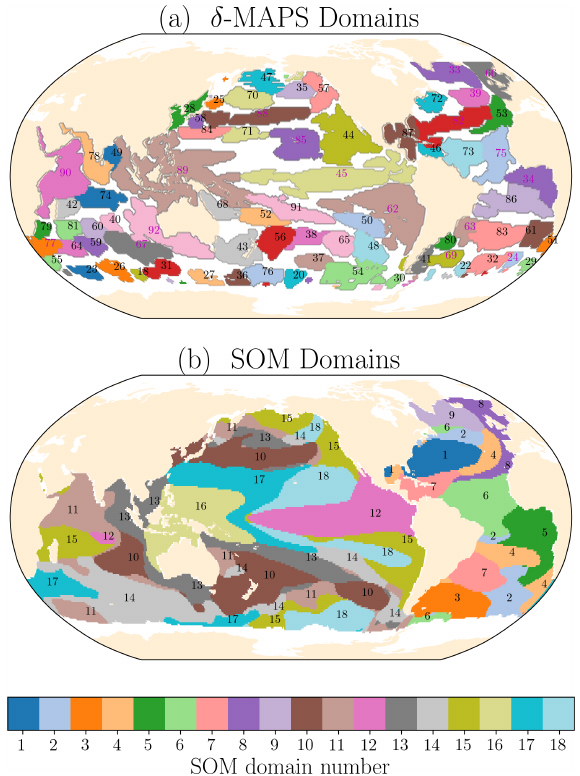
Figure 2. Domains of coherent sea-level variability: (a) δ -MAPS method (92 domains) and (b) self-organizing map (SOM) method (18 domains). Numbers indicate the domain code, and domain names are given in the main text and in Table A1 in the Appendix. δ -MAPS domains with codes in magenta indicate selected domains for Fig. 4. For visibility, small domains have not been labelled. Given the large number of domains, δ -MAPS has a repeating colour pallet, but since δ -MAPS domains need to be continuous, repeated colours do not indicate the same domain. White regions in δ -MAPS indicate incoherent regions, which were not incorporated in any do-